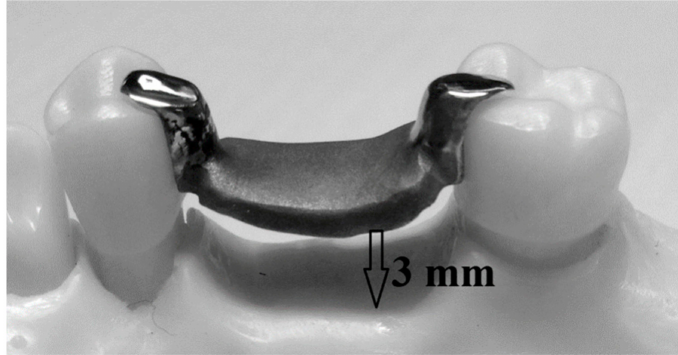
Figure 3. The created space between the saddle and alveolar ridge is 3